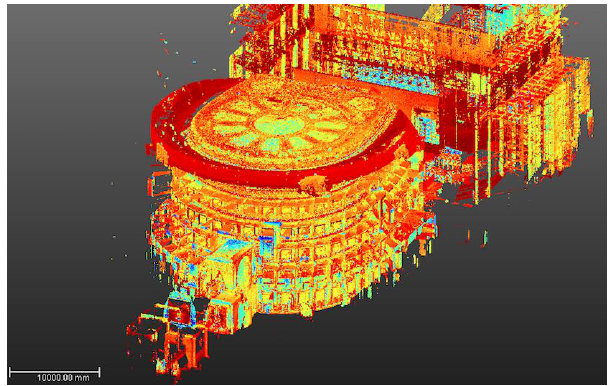
Figure 8. Extraction of the 3D model